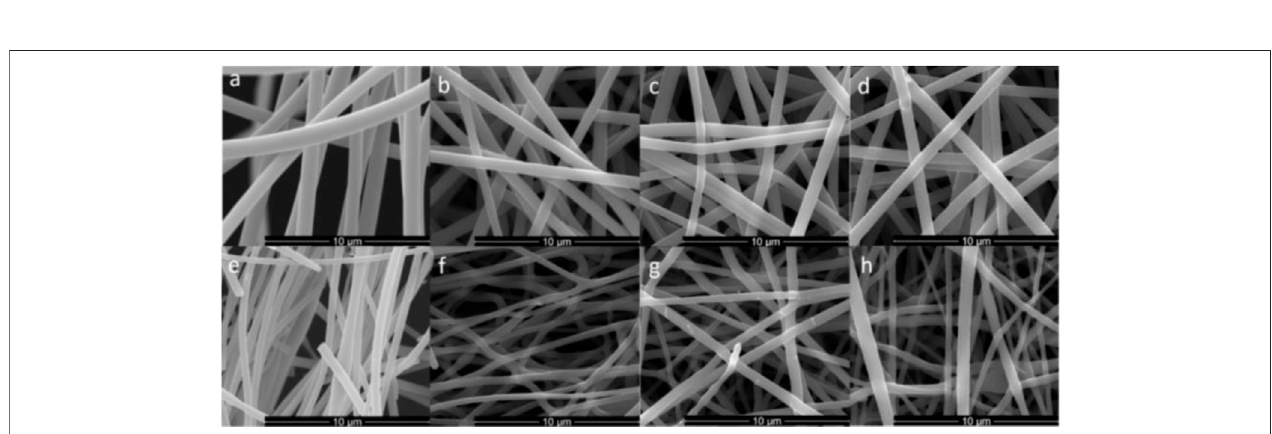
FIGURE 1 | (A) Standard electrospinning setup: A constant fl ow (0.3 ml/h) of a lignin solution is pumped through a blunt needle, which is connected to a high voltage. The solution forms a Taylor cone towards the grounded collector. The evaporation of the solvent and the entanglement of the polymers lead to the formation of electrospun fi bers. (B) Nanospider electrospinning setup:The solution isloaded into acartridge that periodically moved along awire, which isconnected tohigh voltage supply. Through a hole in the cartridge, the containing solution is deposited onto the wire and forms droplets onto the wire surface, which then spray towards a second grounded wireparallel tothe high voltage wire inade fi ned distance.Each droplet forms a Taylor cone, leadingto theformationofa jet of fi bers that deposit onto the target in the form of nonwoven fi bers. Between the two wires, a mesh is placed in order to collect the resulting fi bers.